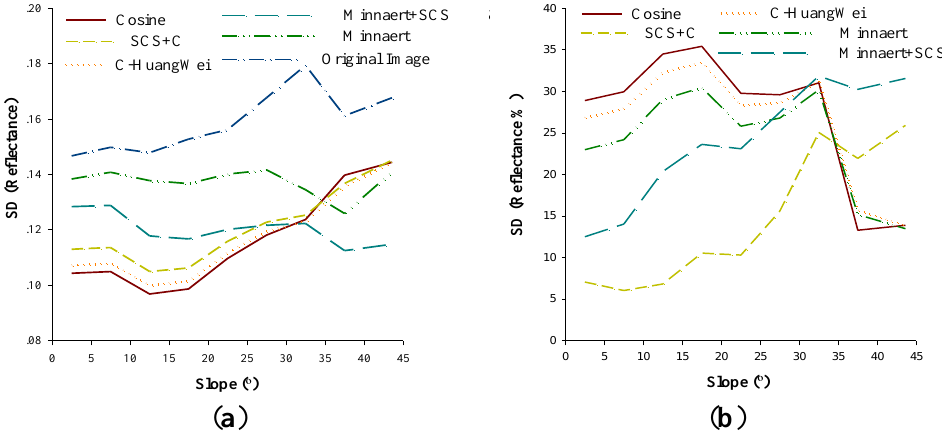
Figure 6. The statistical results of the SD for the original image and five different topographic correction methods. The results obtained under different slope angles are given for the fourth bands. Standard deviation is calculated every 5° (ranging from 0° to 43.6°). ( a ) The SD for the fourth band of the ZY-3 CCD image before and after topographic correction ( b ) The mean reduction (%) of SD compared with the original image (the fourth band) after topographic